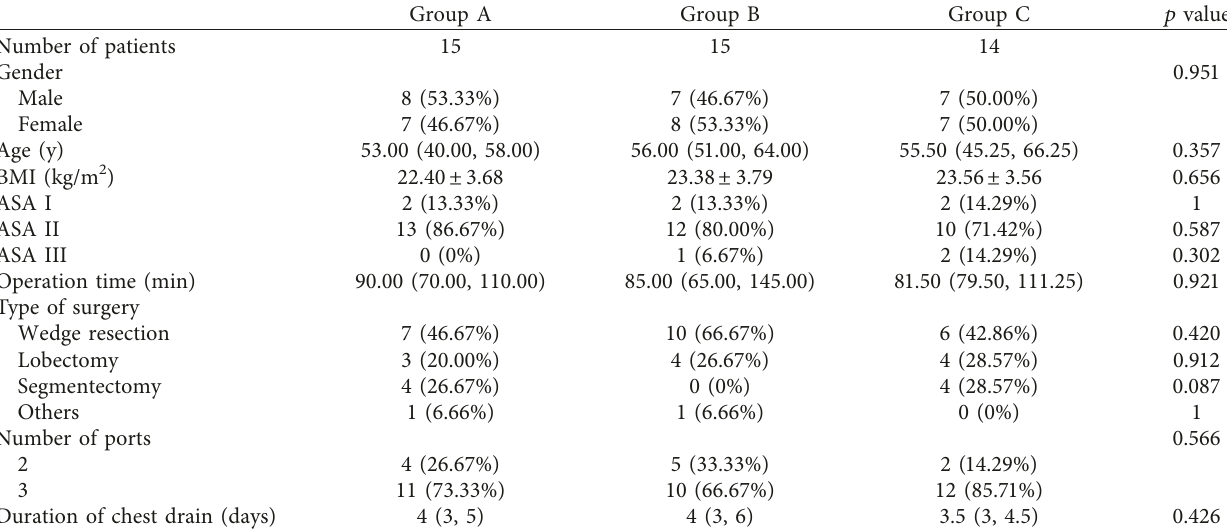
Table 1: Demographic and surgical